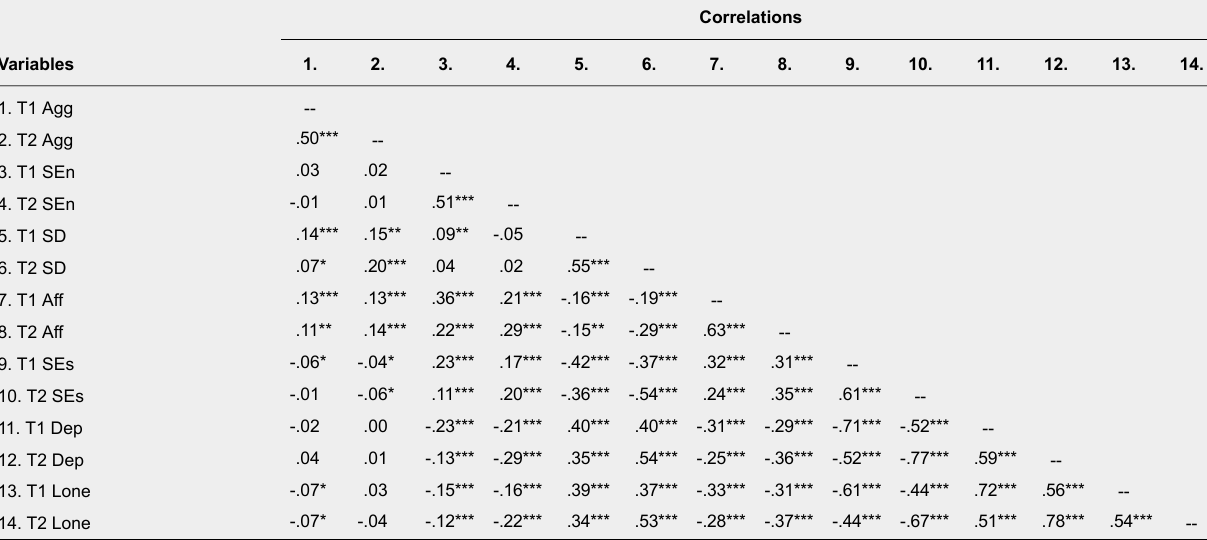
Intercorrelations for Psychosocial Adjustment and Humor Styles at Time 1 and Time 2